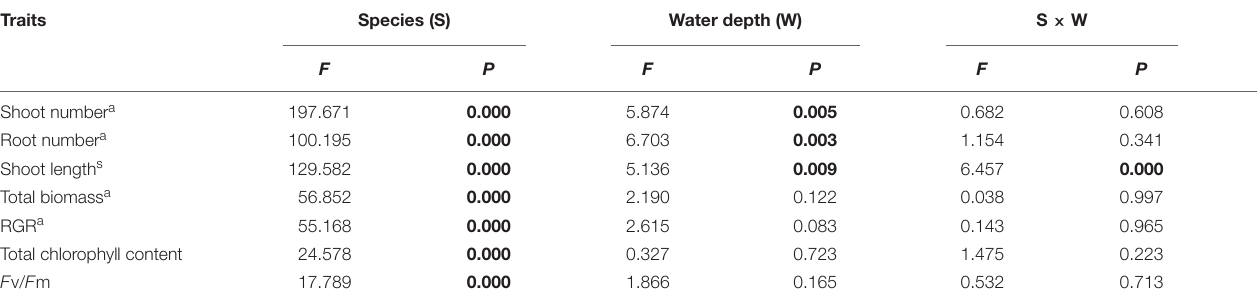
TABLE 1 | F values and P values for species and water depth treatments for shoot number, root number, shoot length, total biomass, RGR, total chlorophyll content and F v/ F m by two-way ANOVA ( n = 7). Traits Species (S) Water depth